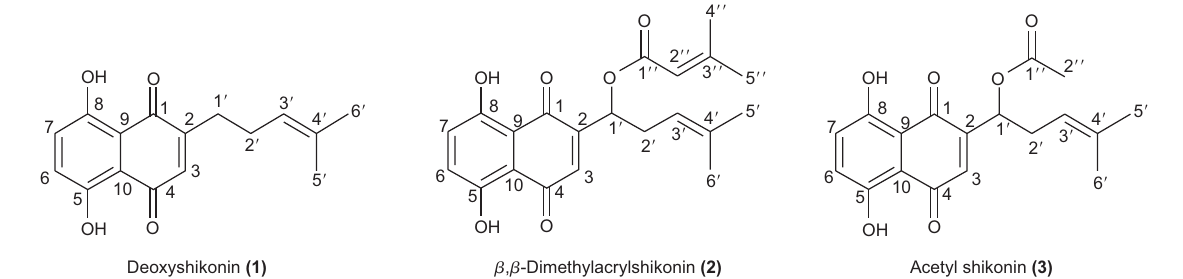
Figure 1 Compounds isolated from O. nigricaule